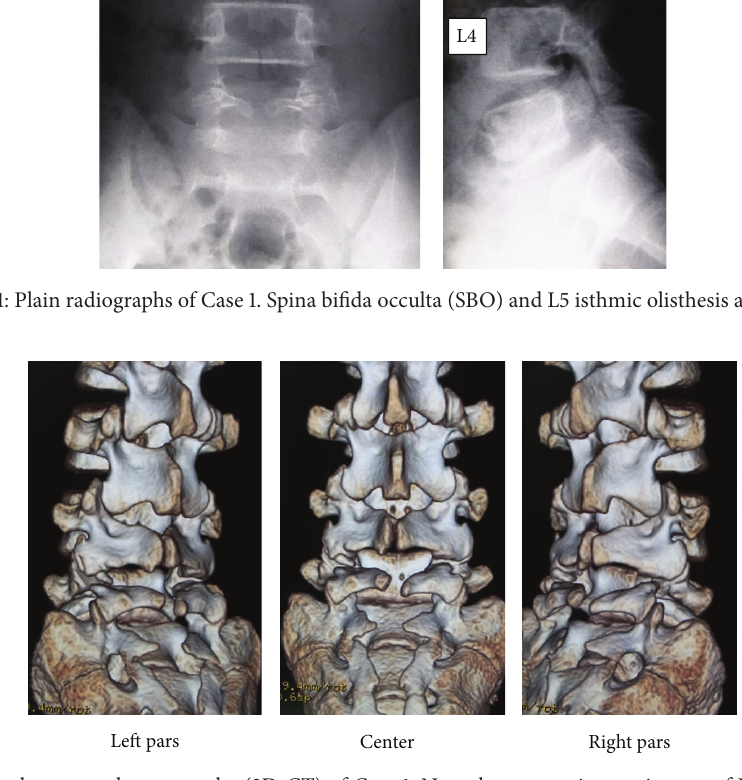
Figure 2: Three-dimensional computed tomography (3D-CT) of Case 1. Note the concomitant existence of L5 bilateral spondylolysis and